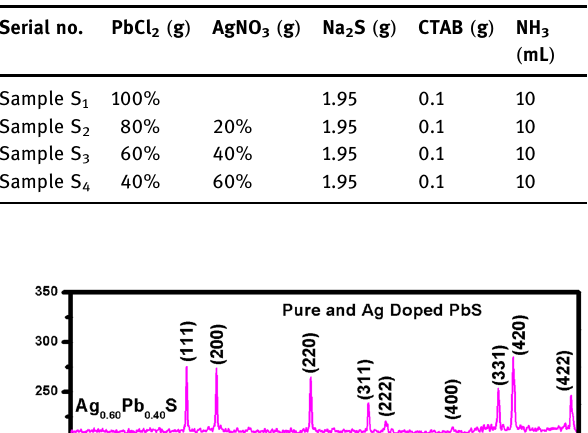
Lattice constant ( a ) states the physical quantity of unit cells. Lattice constants in three dimensions mostly